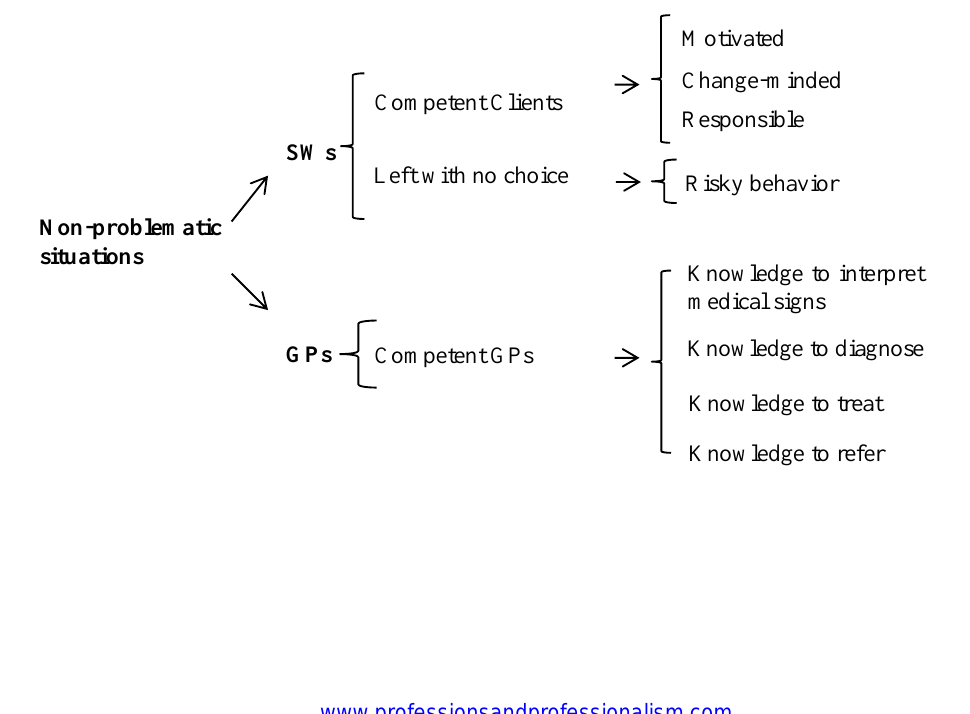
Non-problematic situations in social workers’ and GPs’ professional practice